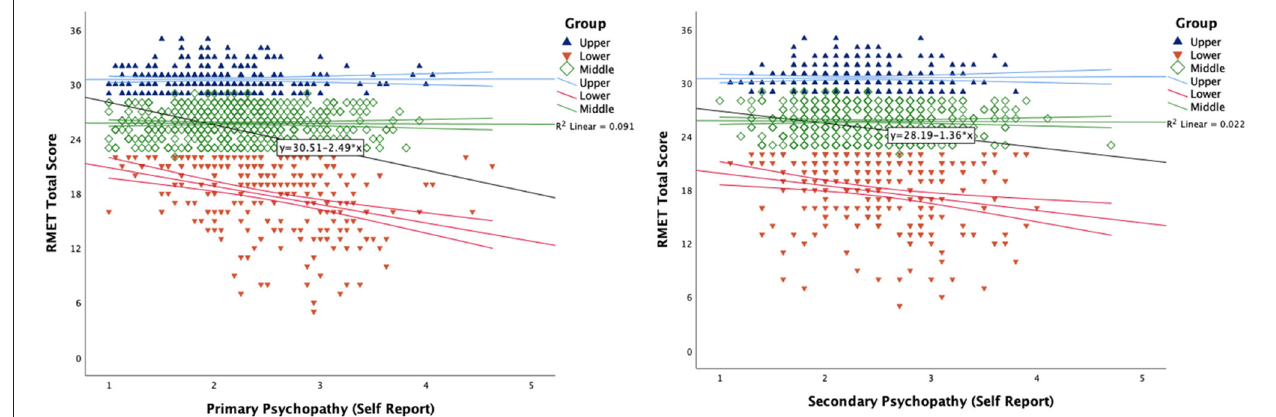
FIGURE 1 | Correlation outcome data on the RMET-36 as well as self-reported outcome data from the Primary (Left) and Secondary (Right). Both figures illustrate the total group, with colour-figure demarcation of those stratified within the Upper Quartile ( n = 250), the Lower Quartile ( n = 250), and those in the Middle group ( n = 500). These figures illustrate the negative relationship from the Lower Quartile between their performance on the RMET total and self-report psychopathy